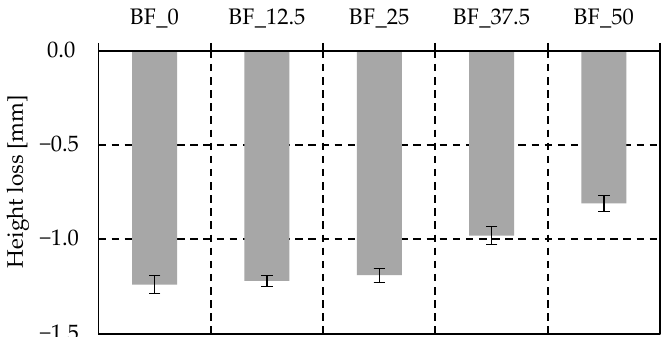
Figure 6. The height loss of tested geopolymers due to abrasion test.